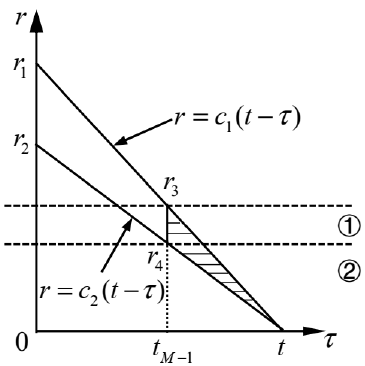
Figure 4. Subdivision of ATI-TSD in time element [ t M − 1 , t